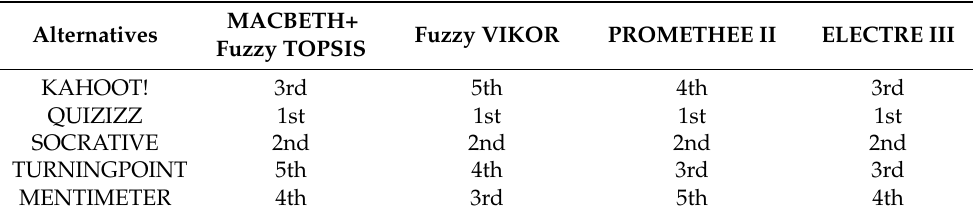
Table 16. Comparison of ranking with different MCDA techniques using objective weights from fuzzy Shannon entropy and subjective weights from MACBETH and W S = 0.5 and W O = 0.5.